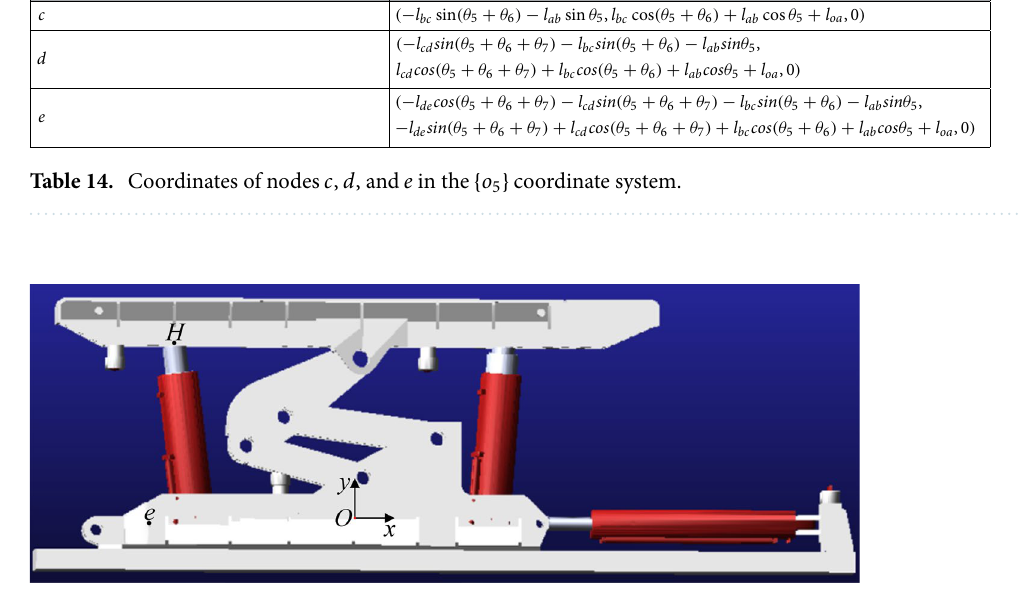
Figure 11. Kinematic simulation model diagram of the advanced hydraulic